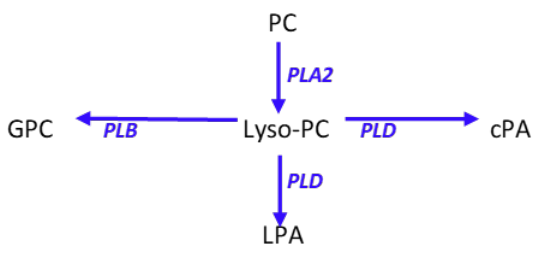
Figure 5. Schematic presentation of phosphatidylcholine (PC) metabolism to lysophosphatidylcholines (lyso-PC) and the associated metabolites cyclic phosphatidic acid (cPA), lysophosphatidic acid (LPA), and glycerophosphocholine (GPC). PLA2, phospholipase A2; PLB, phospholipase B; PLD, phospholipase D.